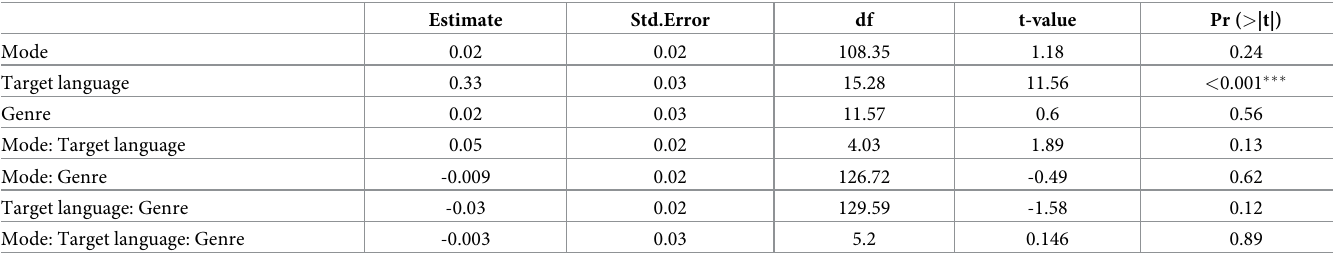
Table 3. Model results for average fixation duration in TT.